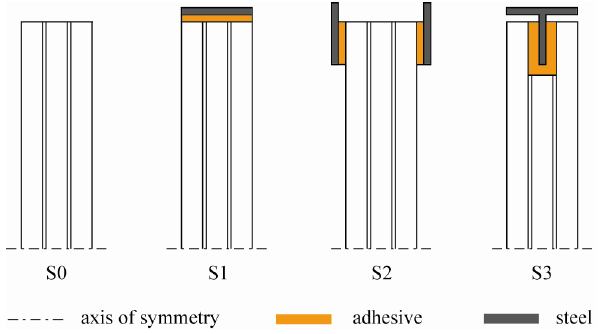
Figure 2: Half cross sections of the tested